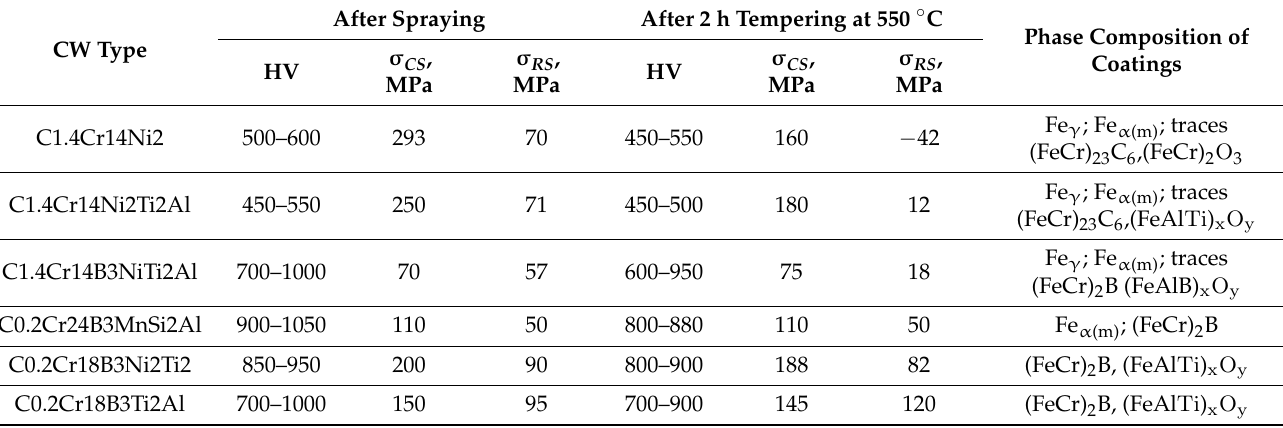
Mechanical characteristics of ASCs deposited by spraying of CWs with different charge